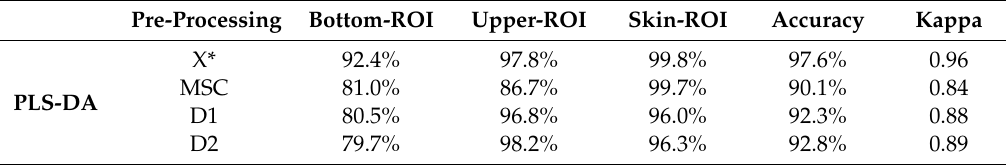
Table 1. Classification result using multivariate analysis method according to pre-processing methods. Pre-Processing